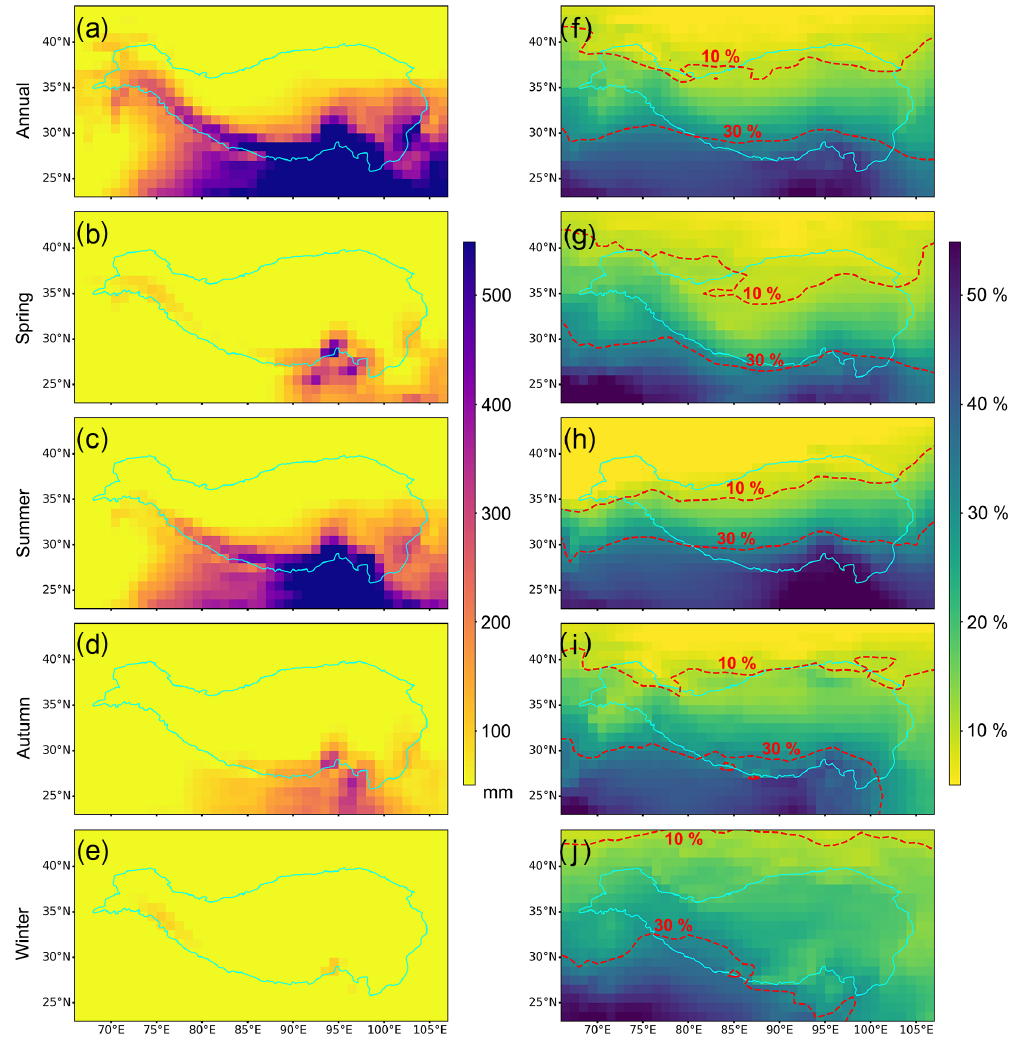
Figure 4. Spatial distributions of long-term mean absolute and relative moisture contributions from the Indian Ocean (IO) to the TP precipi- tation. ( a – e ) The absolute contribution from the IO on annual (mmyr − 1 ) and seasonal (mmseason − 1 ) scales. ( f – j ) The relative contribution of the IO moisture on annual and seasonal scales. The dashed red lines in ( f – j ) are 10% and 30% isolines of the relative contribution. The forward moisture tracking results are modeled by WAM-2layers forced with ERA-Interim during 1979–2015. Moisture-tracking results driven by MERRA-2 (1980–2015) and JRA-55 (1979–2015) are shown in Figs. S9 and S10, respectively.